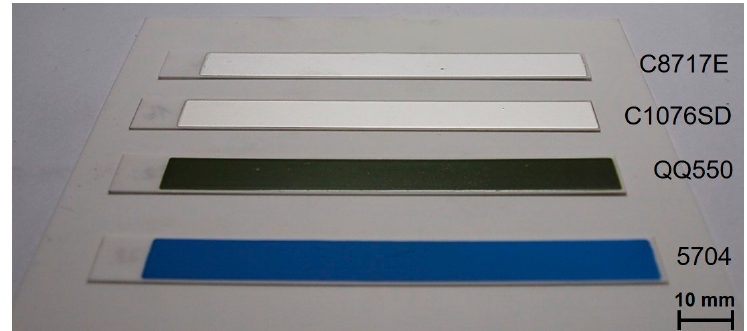
Figure 4. Fired specimens—groups 1–4.